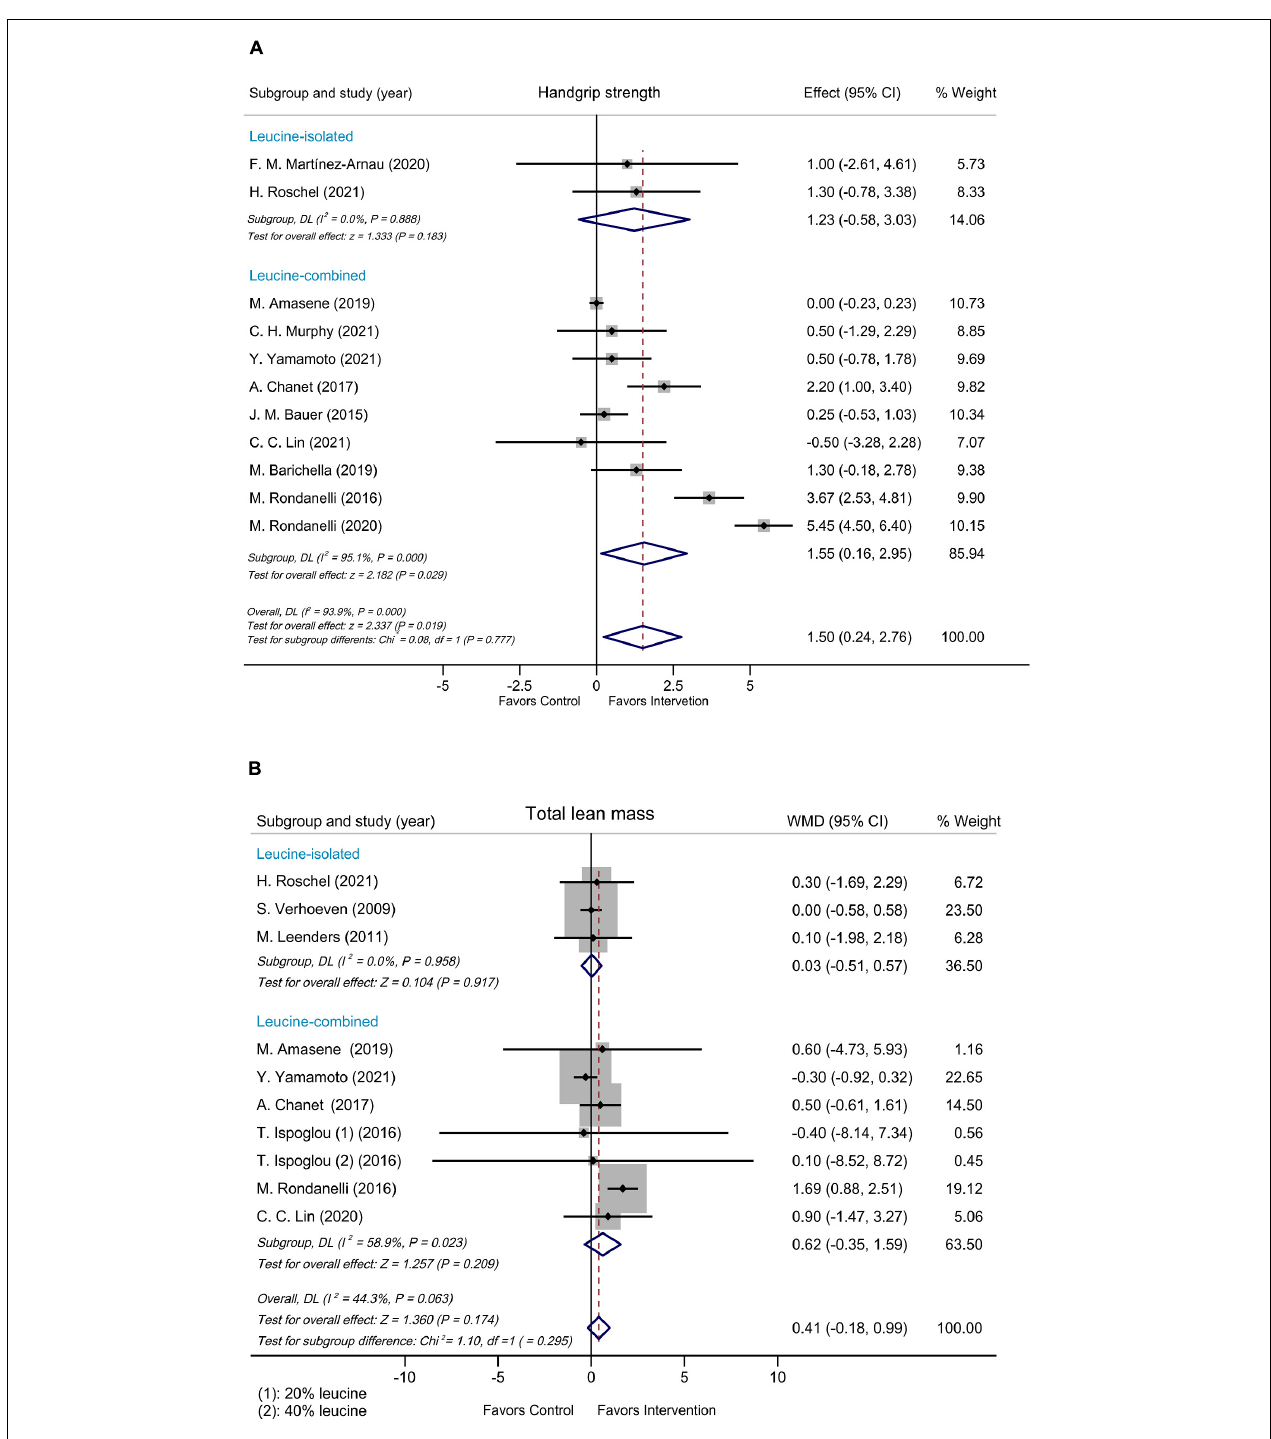
FIGURE 4 | Forest plots assessing the effect on handgrip strength (A) and TLM (B) by leucine-isolated/combined